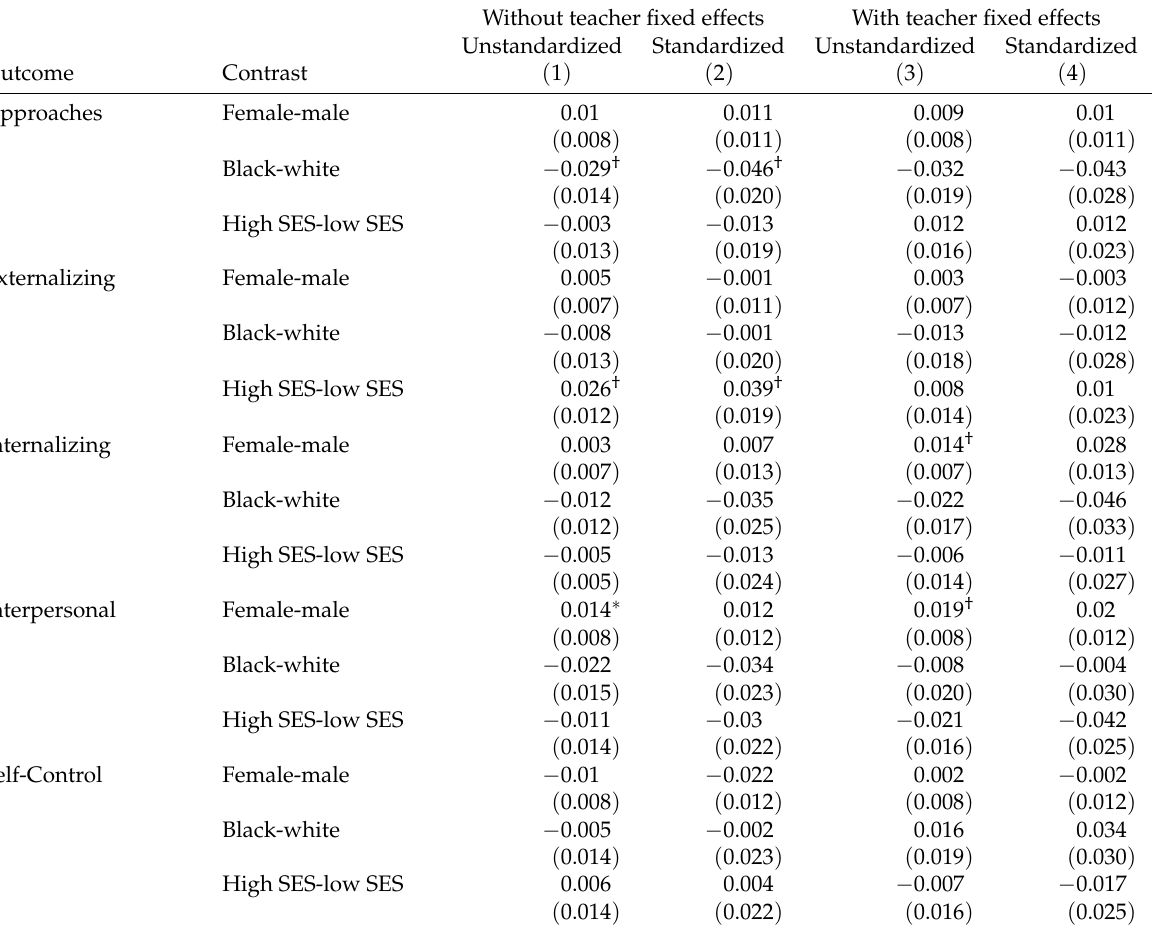
Table 3: Planned contrasts between estimates from the three school years (kindergarten, first grade, and second grade) versus the two summers (summer after kindergarten and summer after first grade; ECLS-K